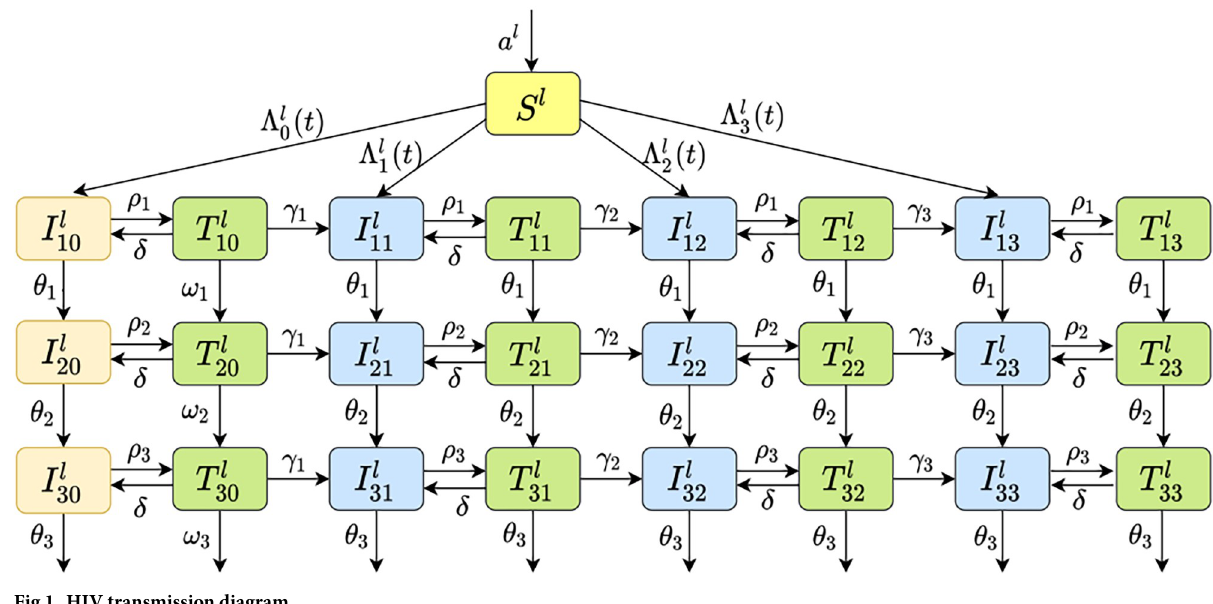
Fig 1. HIV transmission diagram.